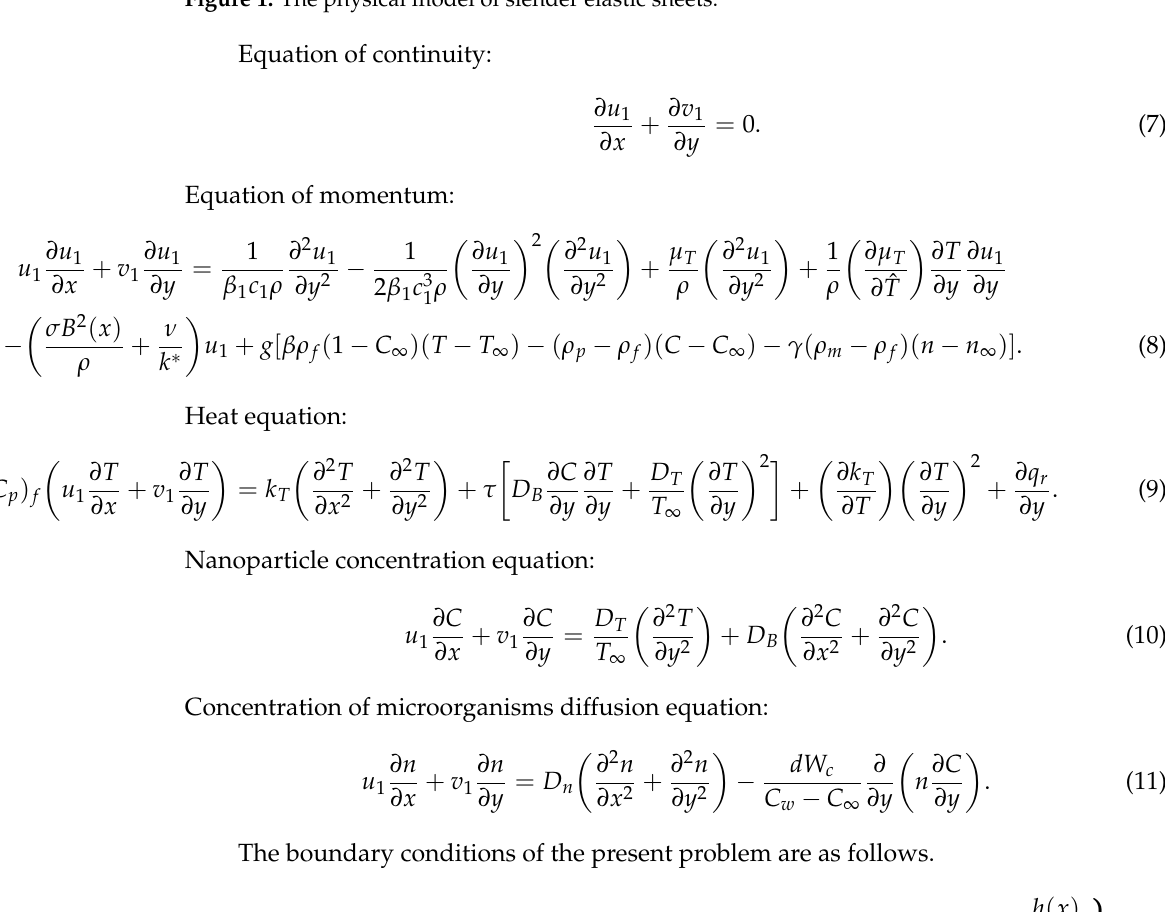
Figure 1. The physical model of slender elastic